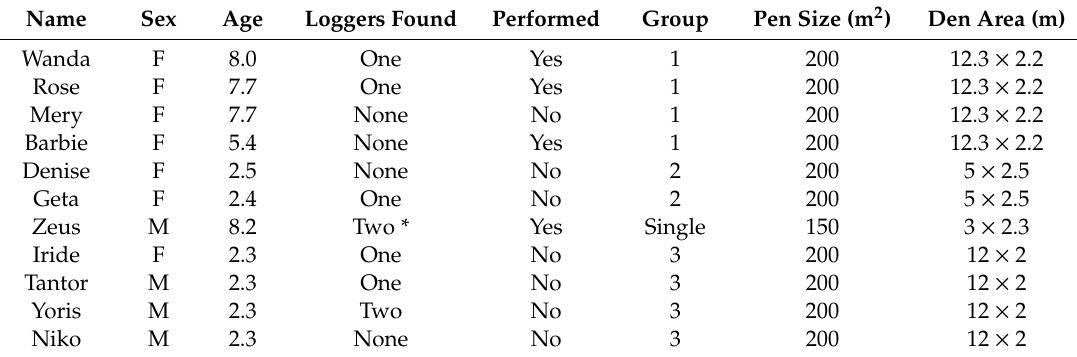
Table 1. Information about the African lions ( Panthera leo ) who were fed body temperature loggers.